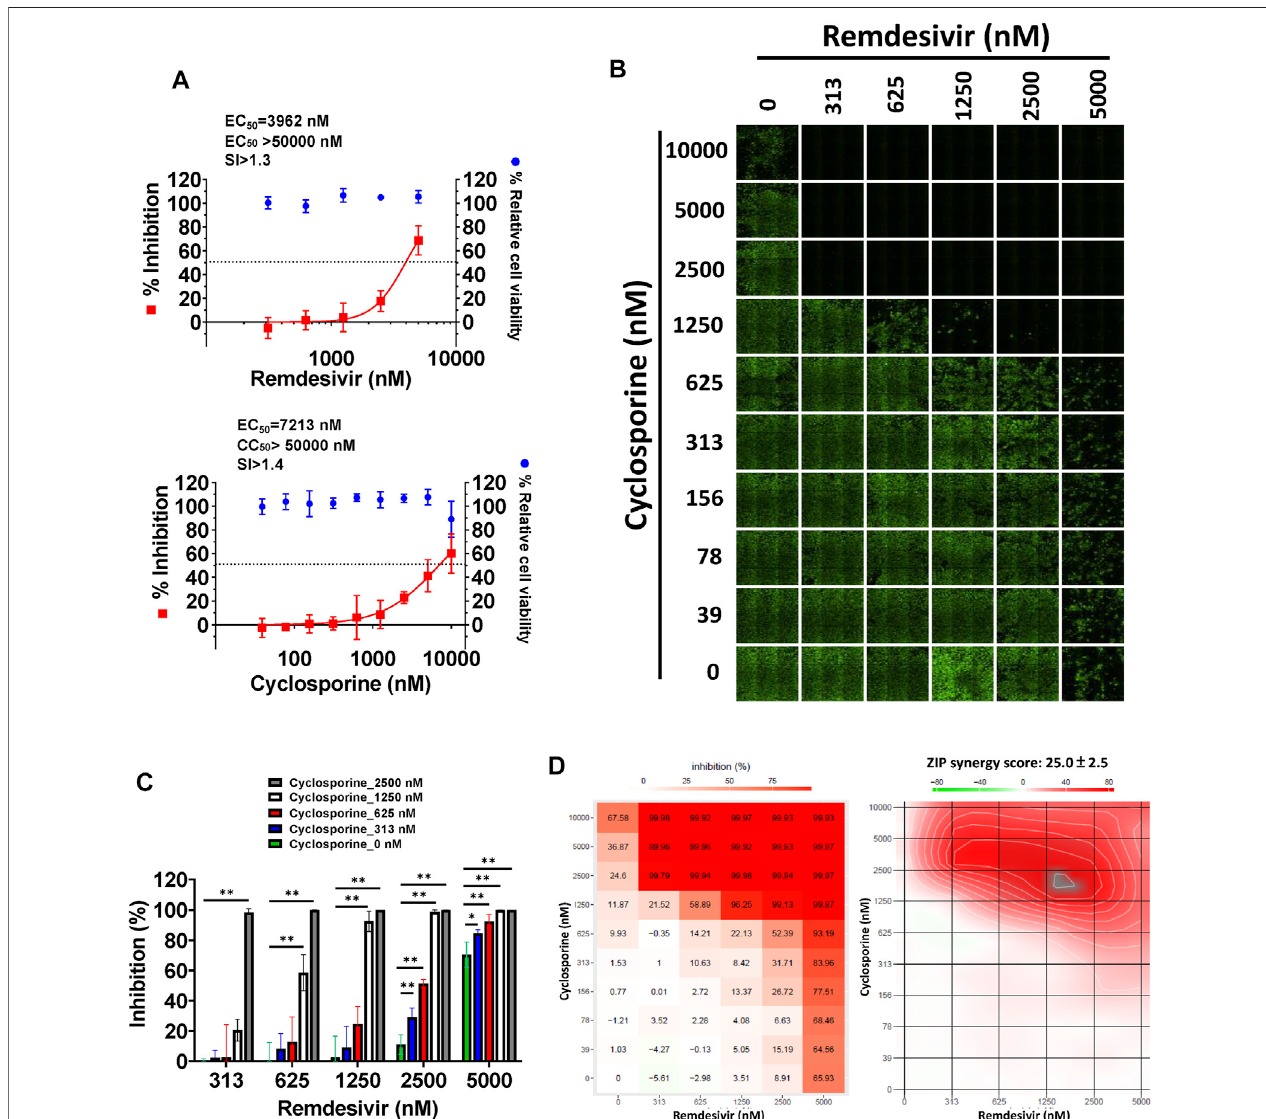
FIGURE 4 | Single or combined treatments of remdesivir and cyclosporine profoundly reduced SARS-CoV-2 infection of Vero E6 cells assayed by IFA. (A) Single treatments of remdesivir and cyclosporine reduced SARS-CoV-2 infection of Vero E6 cells in a dose dependent manner. (B – D) Combined treatments of remdesivir and cyclosporine synergistically reduced SARS-CoV-2 infection in Vero E6 cells. IFAs were performed withantibody against SARS-CoV-2N (green) and DAPI staining(blue) for theVeroE6hostlivecells. VeroE6cells weretreated witheach compound at theindicatedconcentrationsfor 1 hat 37 ° C. Thecellswere adsorbed withSARS- CoV-2 (TCDC#4) at MOI (cid:1) 0.01 for 1 h at 37 ° C. After virus adsorption, the cells were washed with PBS and fresh medium with each compound added at the indicated concentrationsandthenincubatedfor1day.Thecellswere fi xedwith4%paraformaldehydeandpermeabilizedwith0.5%TritonX-100.Thecellswerestainedwithanti- SARS-CoV-2Nproteinantibodyandanti-humanIgG-AlexaFluor488(green).NucleiwerecounterstainedwithDAPI(blue)andusedtodeterminetherelativecellviability by using thenumber ofnuclei invehiclecontrol as100%( Supplementary Figure S3 ).N protein expression was measured using ahigh-content image analysissystem (Molecular Devices). The fl uorescent signalwasnormalizedwith cellviability tocalculate theinfection rate thatnocompound treatment wassetat 100%. EC 50 and CC 50 valueswerecalculatedbyPrismsoftware.ShownaretheAVE ± SDfromthreeindependentexperiments (AandC) *and**denotestatisticalsigni fi canceof p < 0.05,and p < 0.01 respectively. Shown results of IFA are representative of three independent experiments (B) . Shown inhibition % (AVE) and synergy scores (AVE ± SD) are from three independent experiments (D) analyzed via SynergyFinder (https://synergy fi nder. fi mm. fi /).